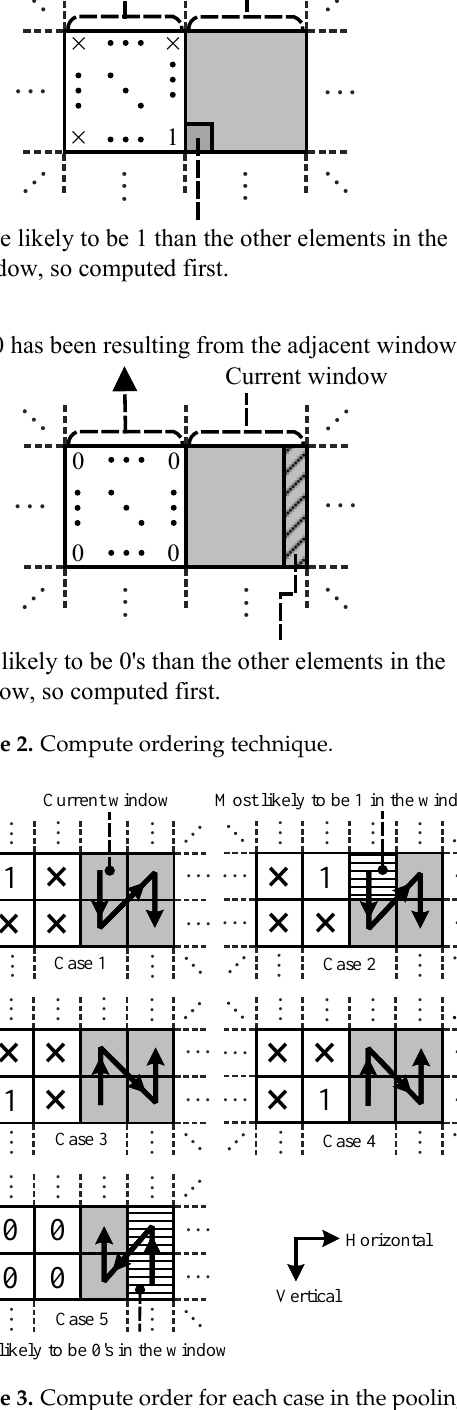
Figure 3. Compute order for each case in the pooling window of size 2 ×